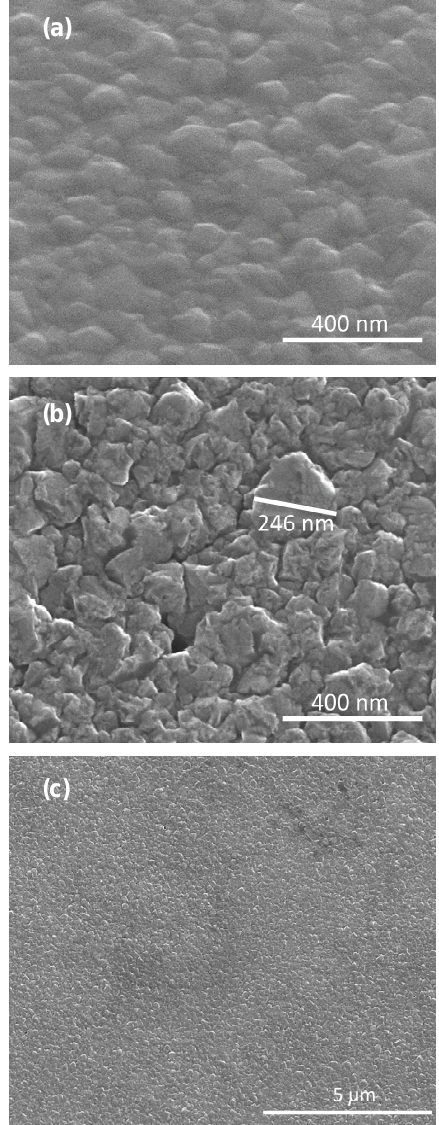
Fig. 9. SEM images of the surface of the initial Si(111)/c-plane Al O sample (a) and the same sam- 2 3 ple after conversion into SiC by reaction (1) (b, c); (c) is the same area as in fig. (b) but on a smaller